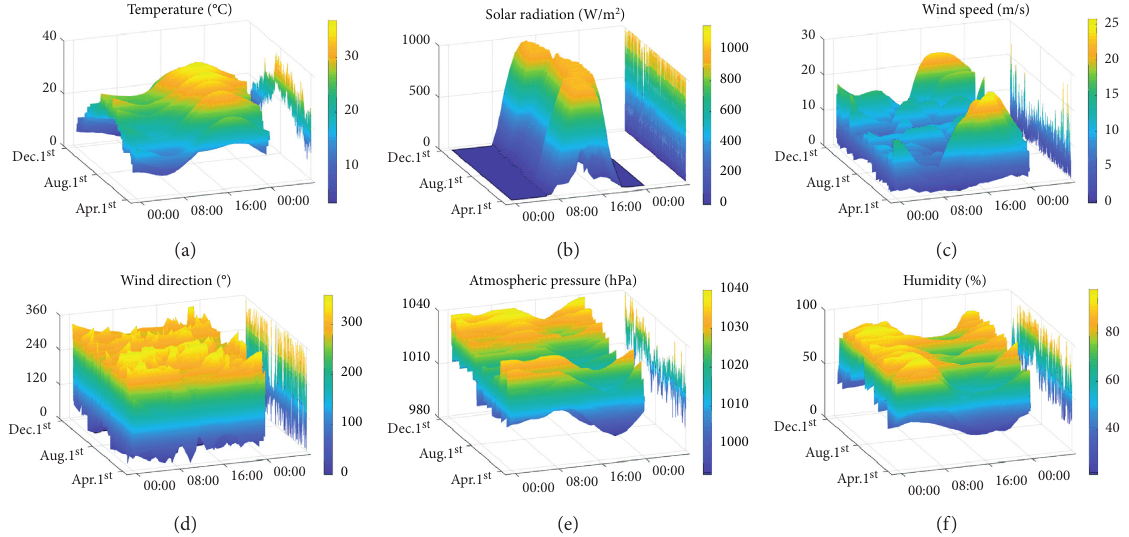
Figure 3: The data of temperature, solar radiation, and meteorological information: (a) temperature, (b) solar radiation, (c) wind speed, (d) wind direction, (e) atmospheric pressure, and (f)